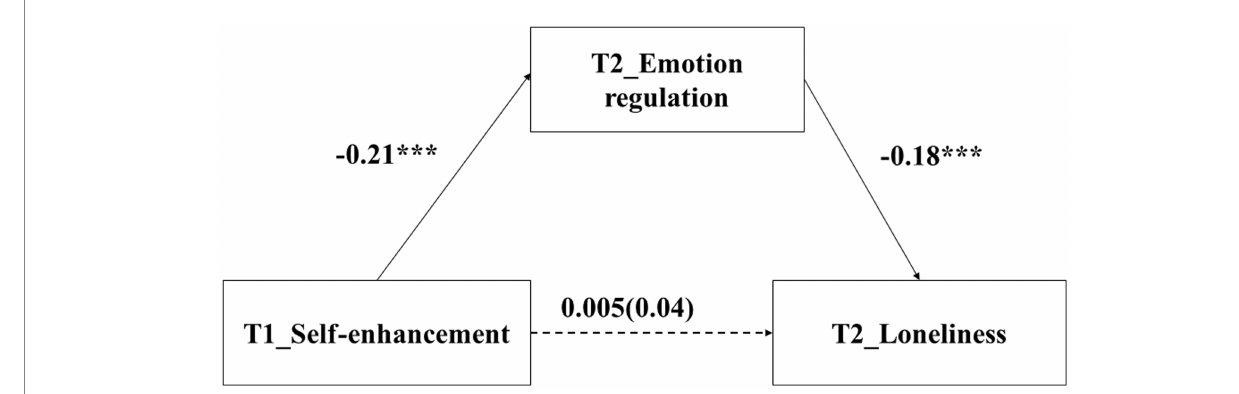
FIGURE 4 The mediating effect of emotion regulation. *** p < 0.001.